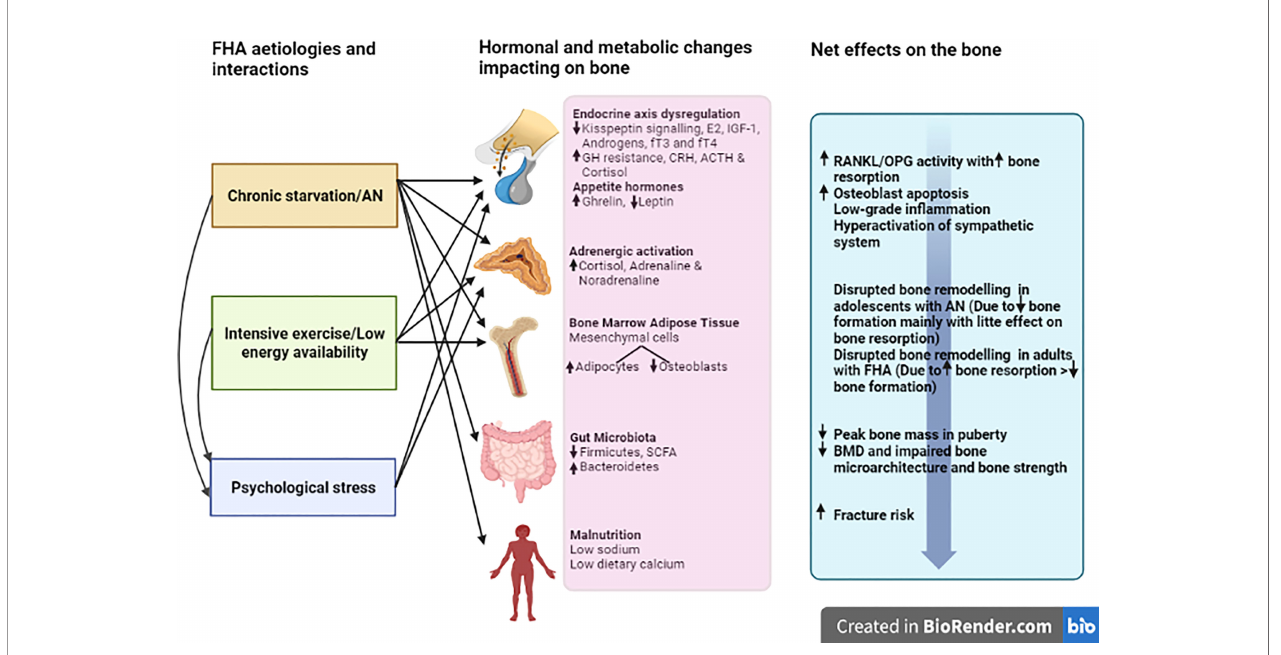
FIGURE 1 | Pathophysiology and the effects of FHA on